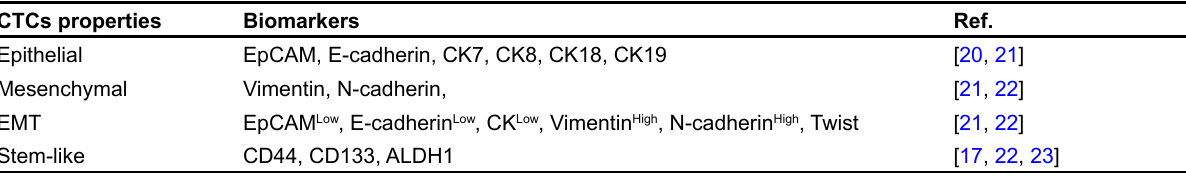
Table 1. CTCs properties and related markers associated with EMT program in lung cancer CTCs properties Biomarkers